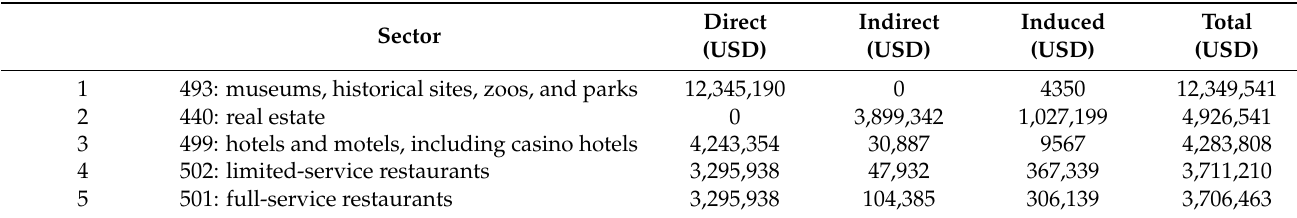
Table A14. Top Five Affected Sectors by Revenue.